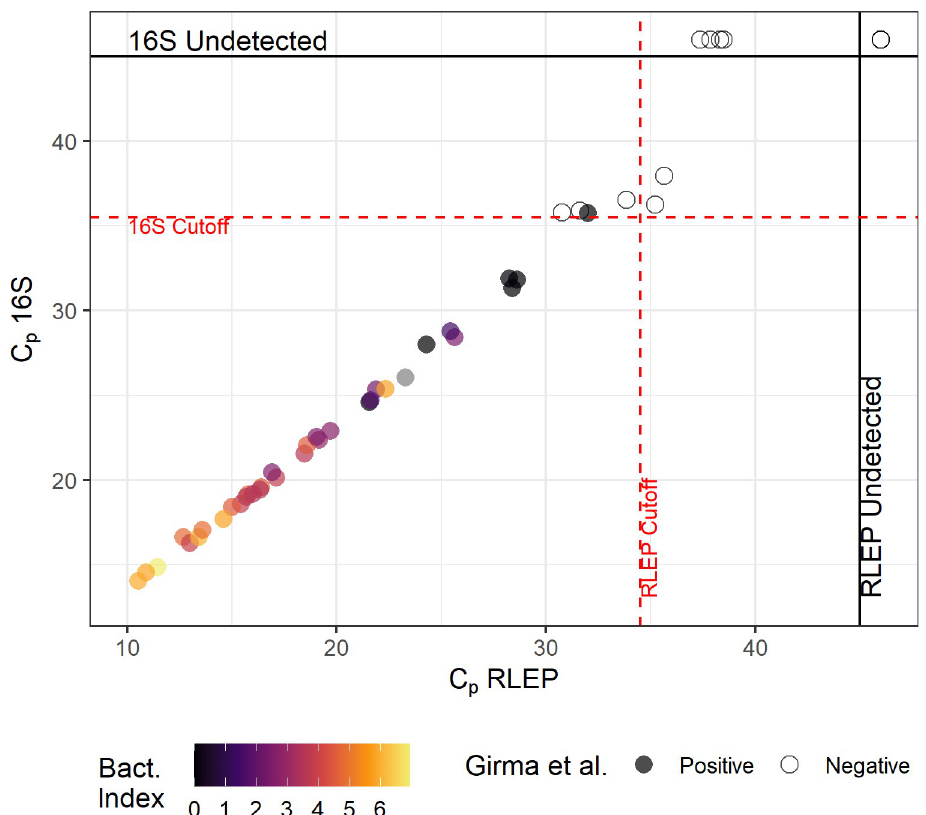
Fig 6. Validation of parameters with an independent sample panel. Samples previously characterized by Girma et al [32] were subjected to the new qPCR described in the present study. Each point represents a different sample. Filled circles represent leprosy samples and open dots represent negative samples. Points aligned to the top and right margins indicate samples in which 16S rRNA or RLEP, respectively, were not detected within 45 cycles. Bacterial index is shown as a color gradient (samples for which bacterial index information was not available are filled in gray). Dotted red lines indicate the cutoff values from Table